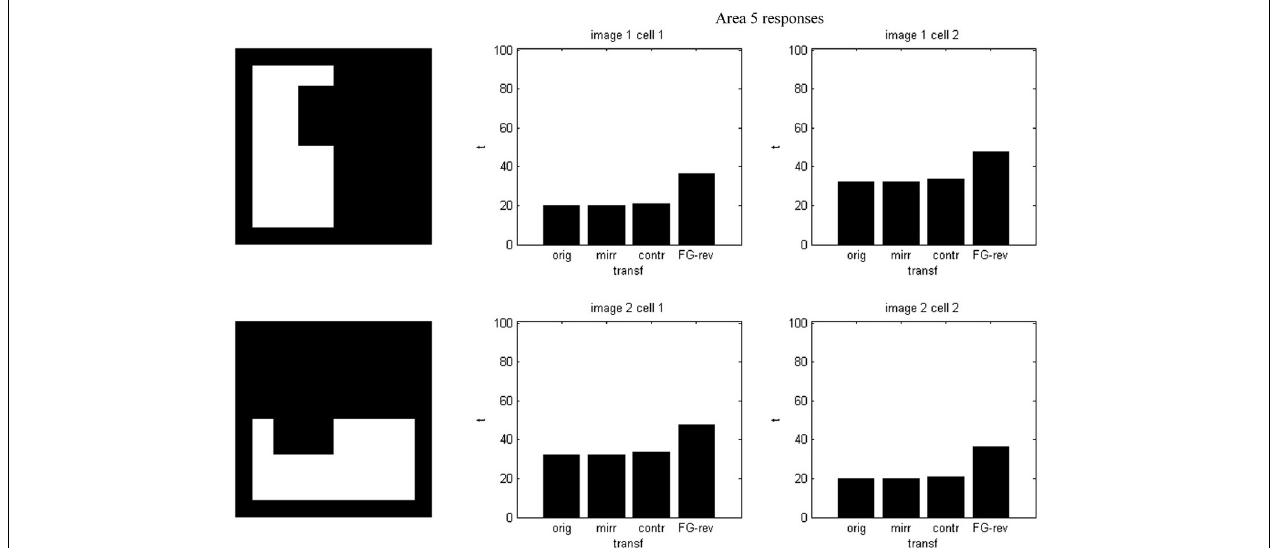
FIGURE 10 | Firing onset times for the images of Figure 8. Cell 1 and cell 2 times are interchanged.